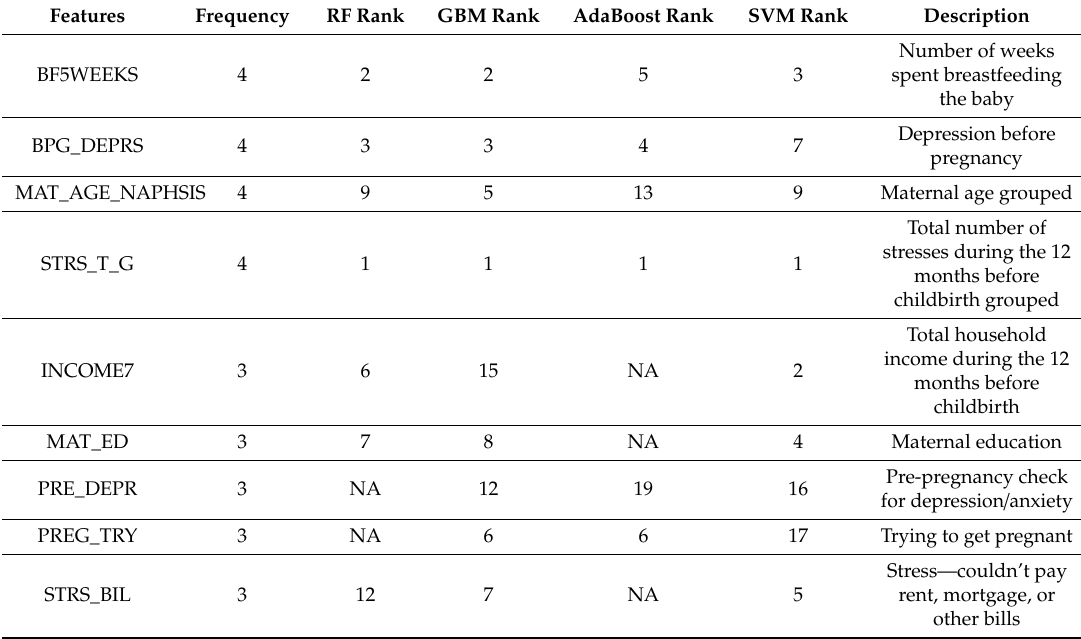
Table 4. The most contributing features belonging to at least three of the best four